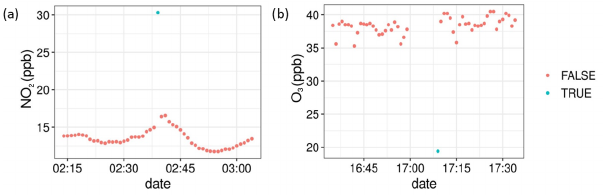
Figure 5. Examples of outliers detected on reference data using a z test with running mean for the SC. A value of “TRUE” means the point was deemed an outlier by the z test.